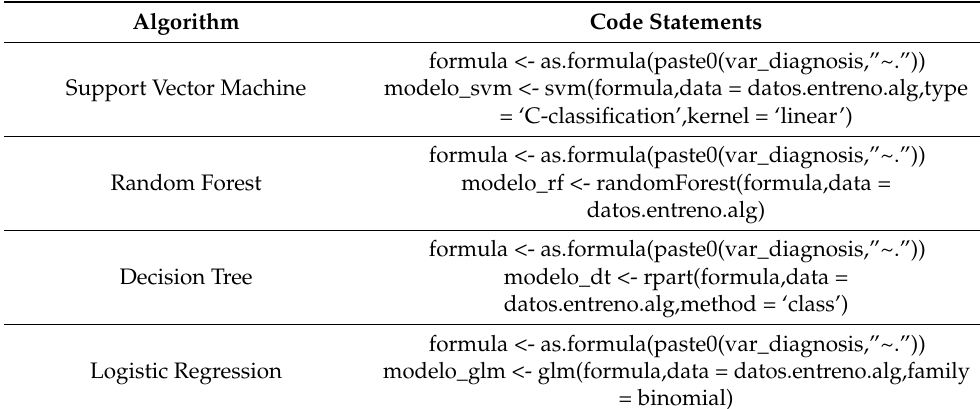
Table 6. Parametrization used for the generation of machine learning models.